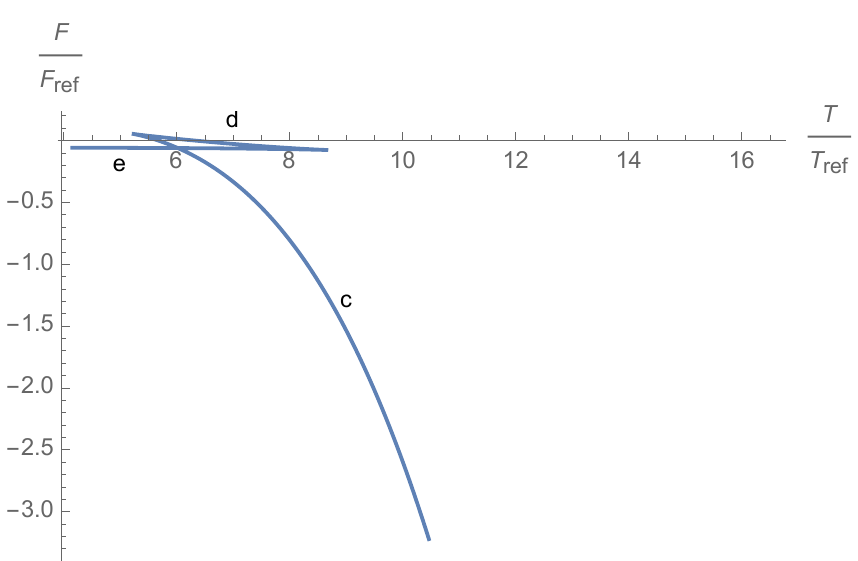
Figure 23 . Free energy of bouncing type solutions in region I as a function of T that follows from the potential in (cid:12)gure 18. Latin letters label the di(cid:11)erent branches shown in (cid:12)gure 21.